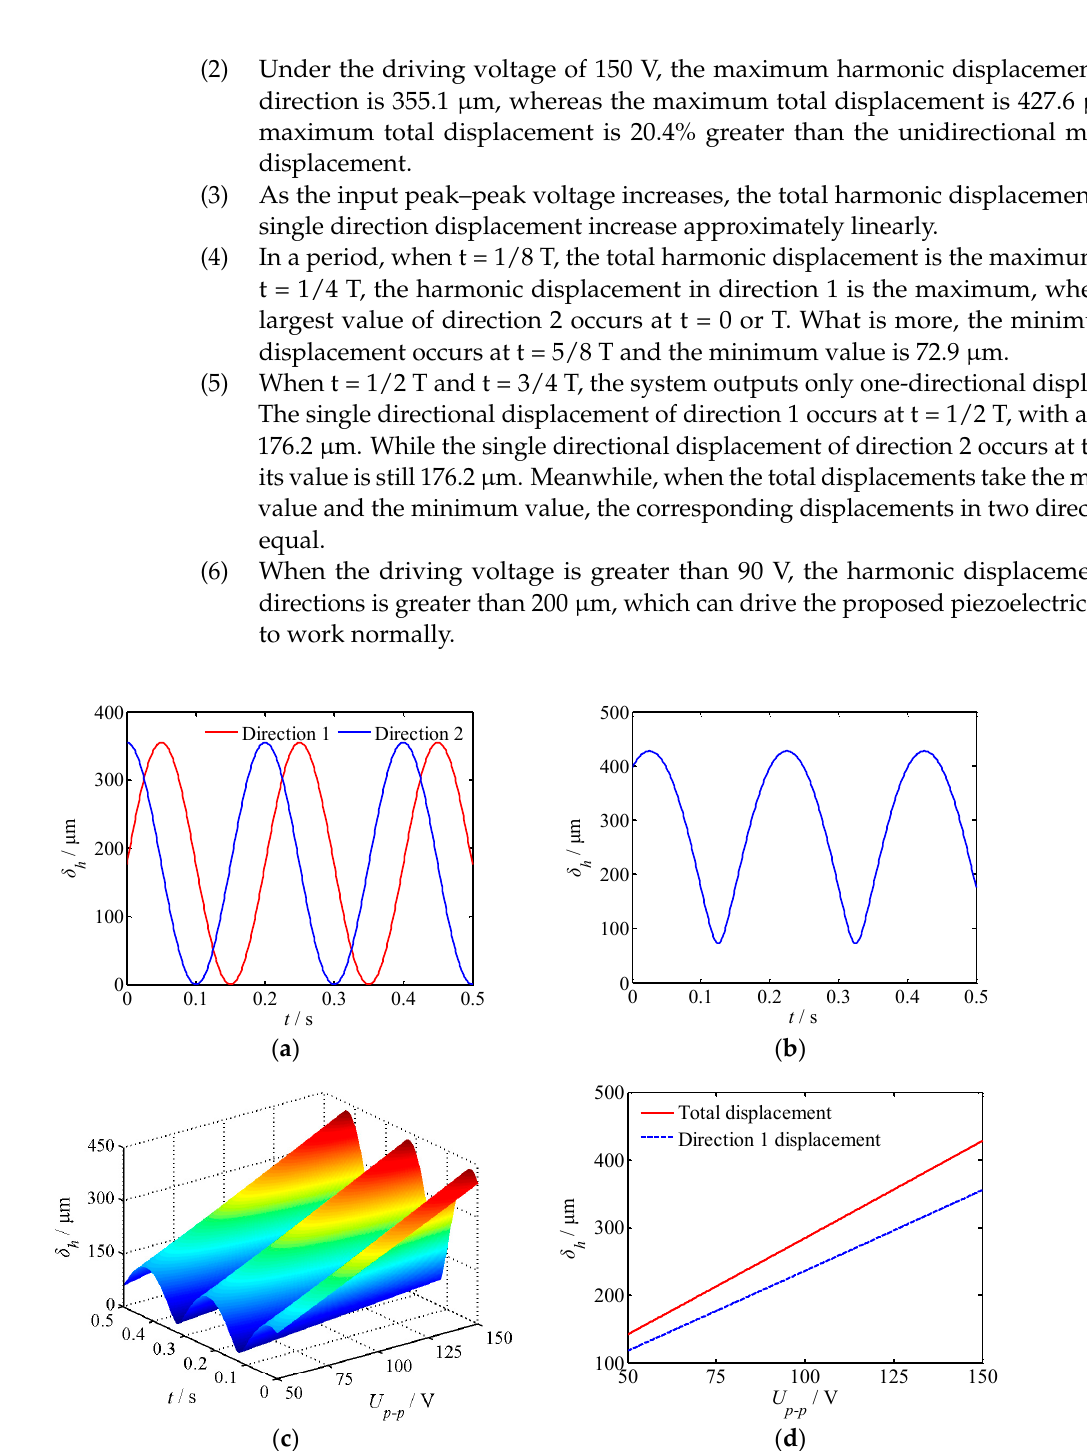
( g ) Figure 10. Harmonic displacements at different periods. ( a ) t = 0; ( b ) t = (cid:2869) (cid:2876) 𝑇 ; ( c ) t = (cid:2869) (cid:2872) 𝑇 ; ( d ) t = (cid:2869) (cid:2870) 𝑇 ; ( e ) t = (cid:2873) (cid:2876) 𝑇 ; ( f ) t = (cid:2871) (cid:2872) 𝑇 ; ( g ) t = T .